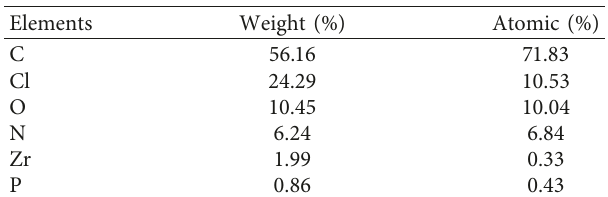
Figure 6: LSV of PANI/PVC-PEDOT: PSS-ZrP membrane. Table 2: Elemental composition of the PANI/PVC-PEDOT: PSS- ZrP composite ionomer